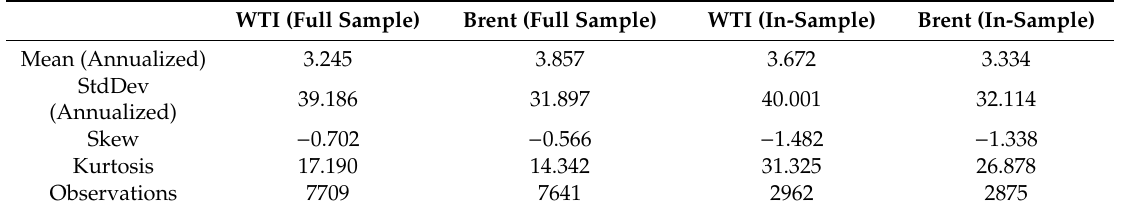
Table 1. Descriptive statistics of the West Texas Intermediate (WTI) and Brent crude oil returns. WTI (Full Sample) Brent (Full Sample) WTI